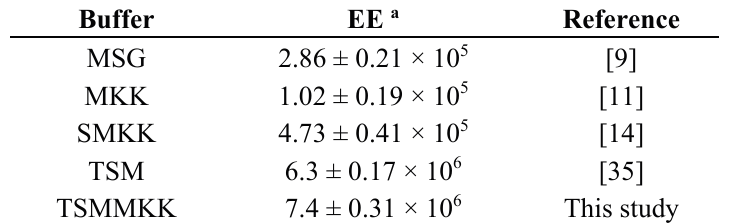
Table 5. Effects of electroporation buffers on the electroporation